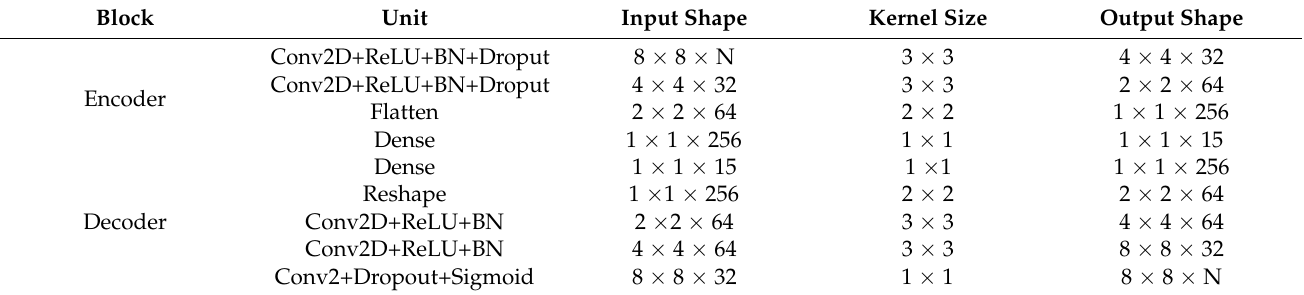
Table 6. The configuration of the designed convolutional autoencoder for feature